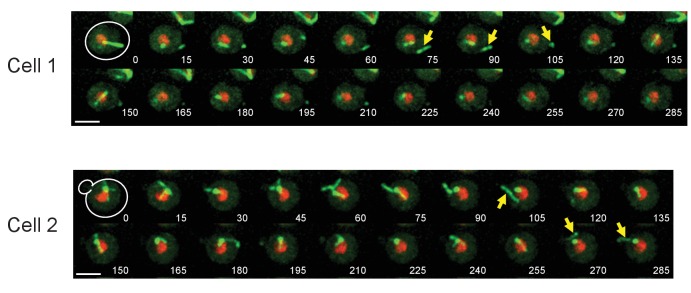
Time-lapse microscopy of GFP-TUB1 HHT1-mCherry cells.Representative images of time-lapse microscopy in GFP-TUB1 HHT1-mCHerry cells (HPH164). Cells were grown in SD complete medium at 30°C. Consecutive sections were taken every 30 s. Yellow arrows point cMTs detached from SPB. Scale bar, 2 µm.